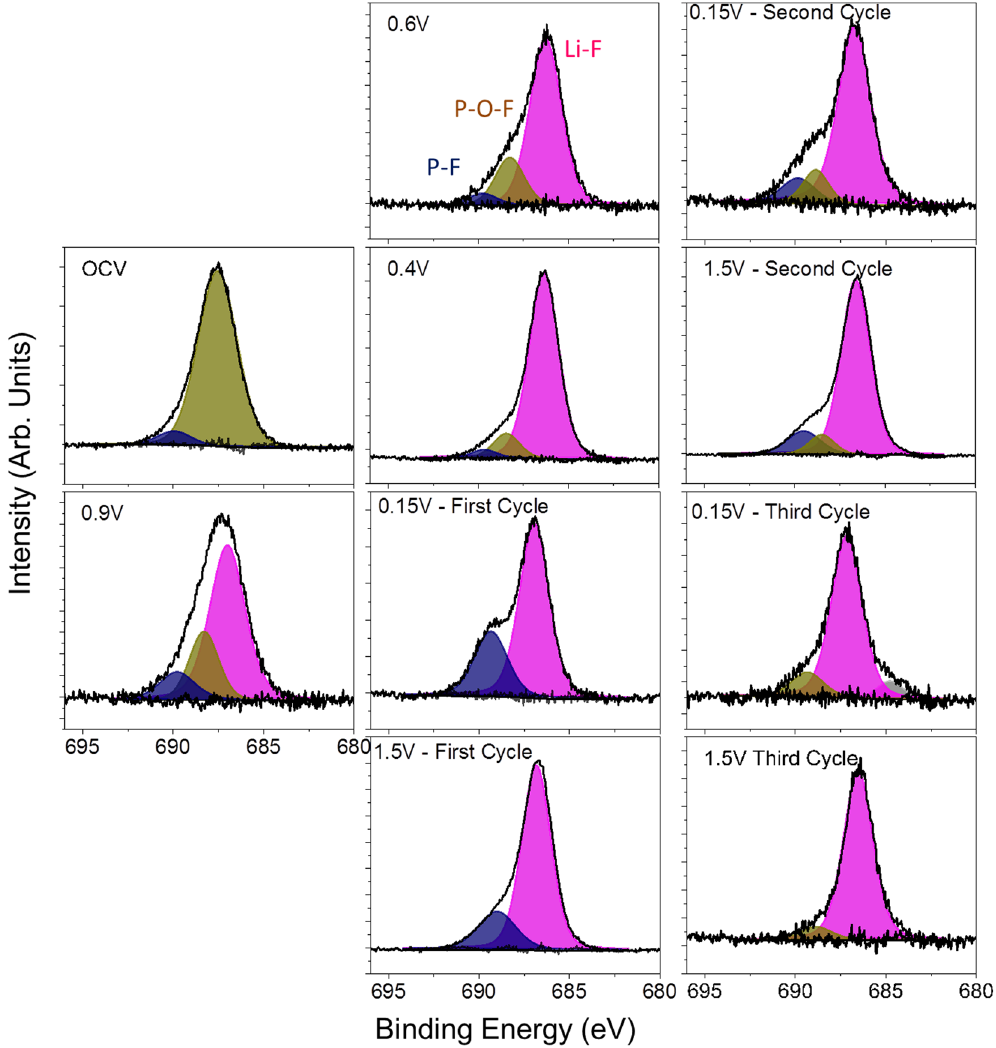
Figure 7. F1s XPS data collected for the witness